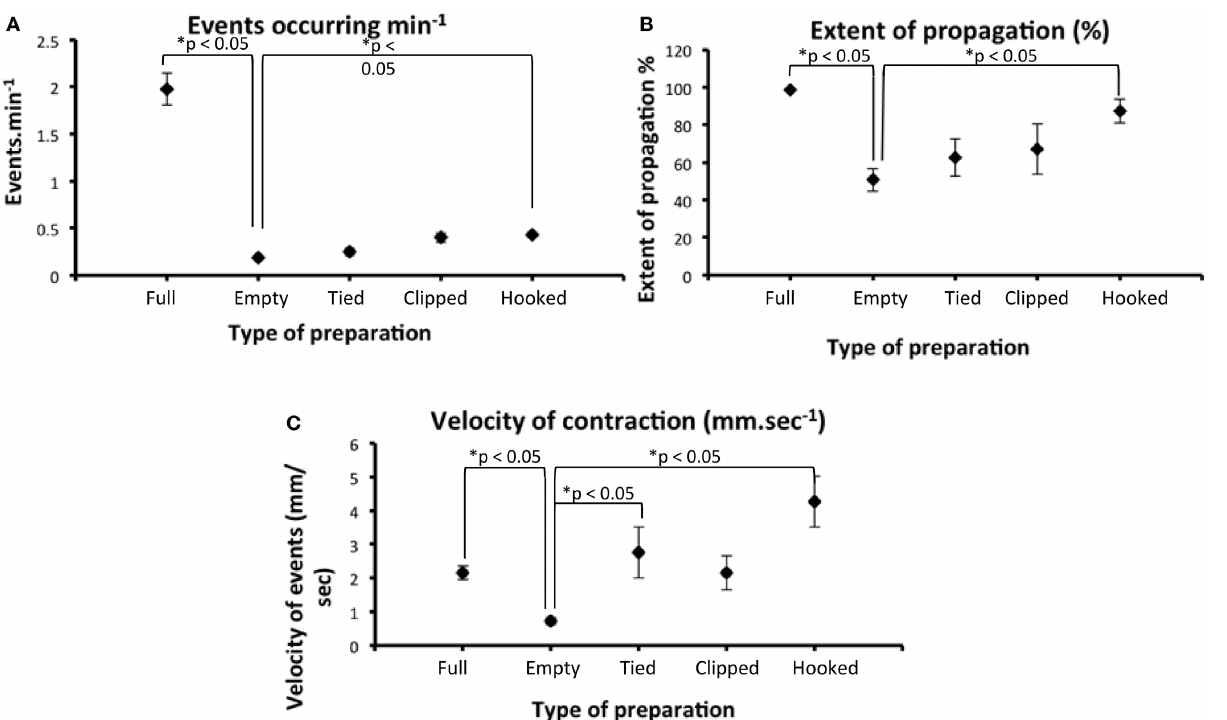
FIGURE 5 | There was a statistically significant reduction in the number of CMMCs that occurred per minute in full segments of colon (that lacked luminal contents) compared with the same segments that contained multiple endogenous pellets. (A) empty preparations which had hooks applied and 1gm tension imposed induced a significant increase in CMMC frequency (compare Empty data set with Hooked data). “Tied” refers to when the colon is cannulated at the oral and anal ends with suture thread and “clipped” refers to when the preparations have